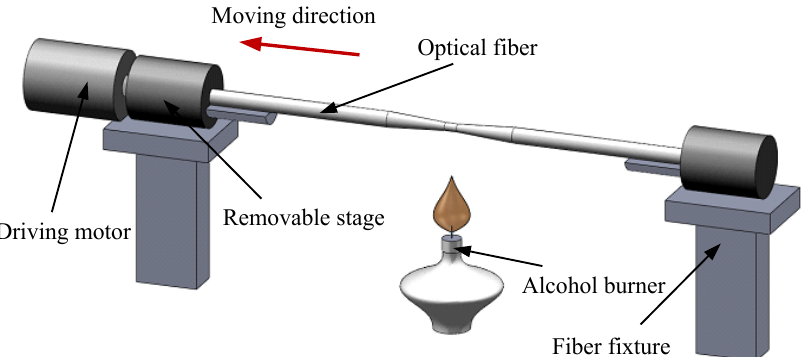
Figure 11. Schematic diagram of optical fiber tapering